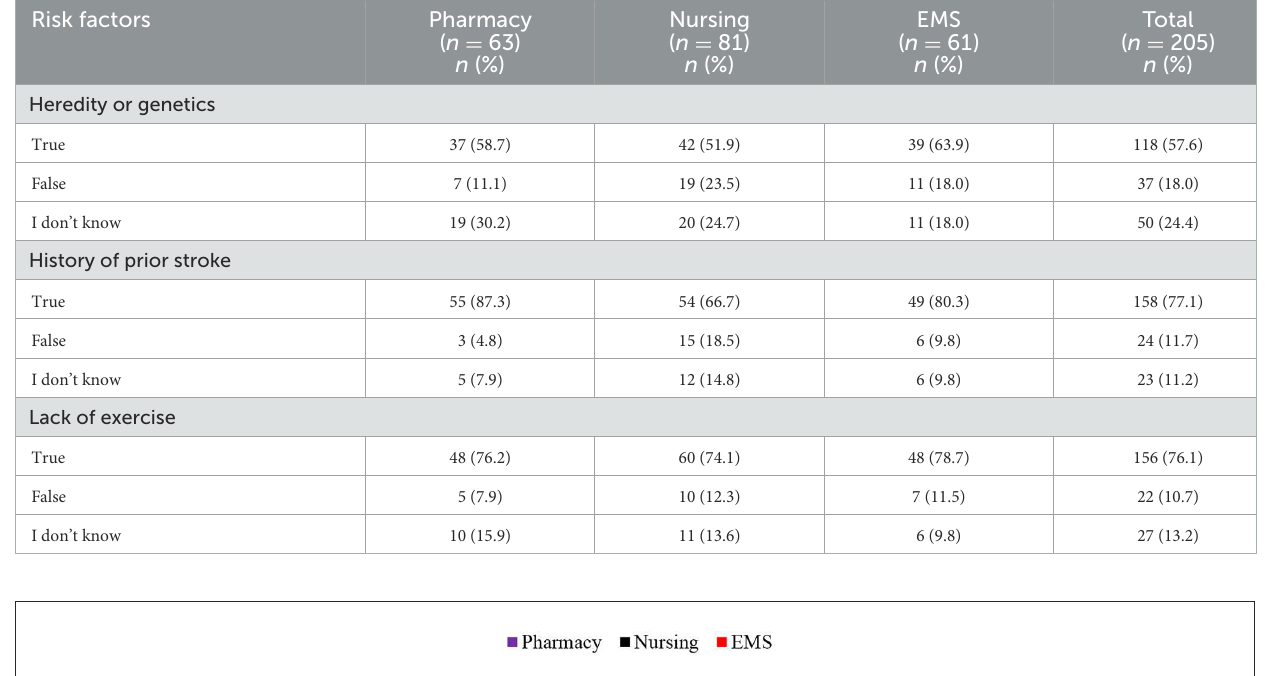
dizziness and a similar percentage was found in both groups pharmacy and nursing ( ∼ 76.5%). More details can be found in Table